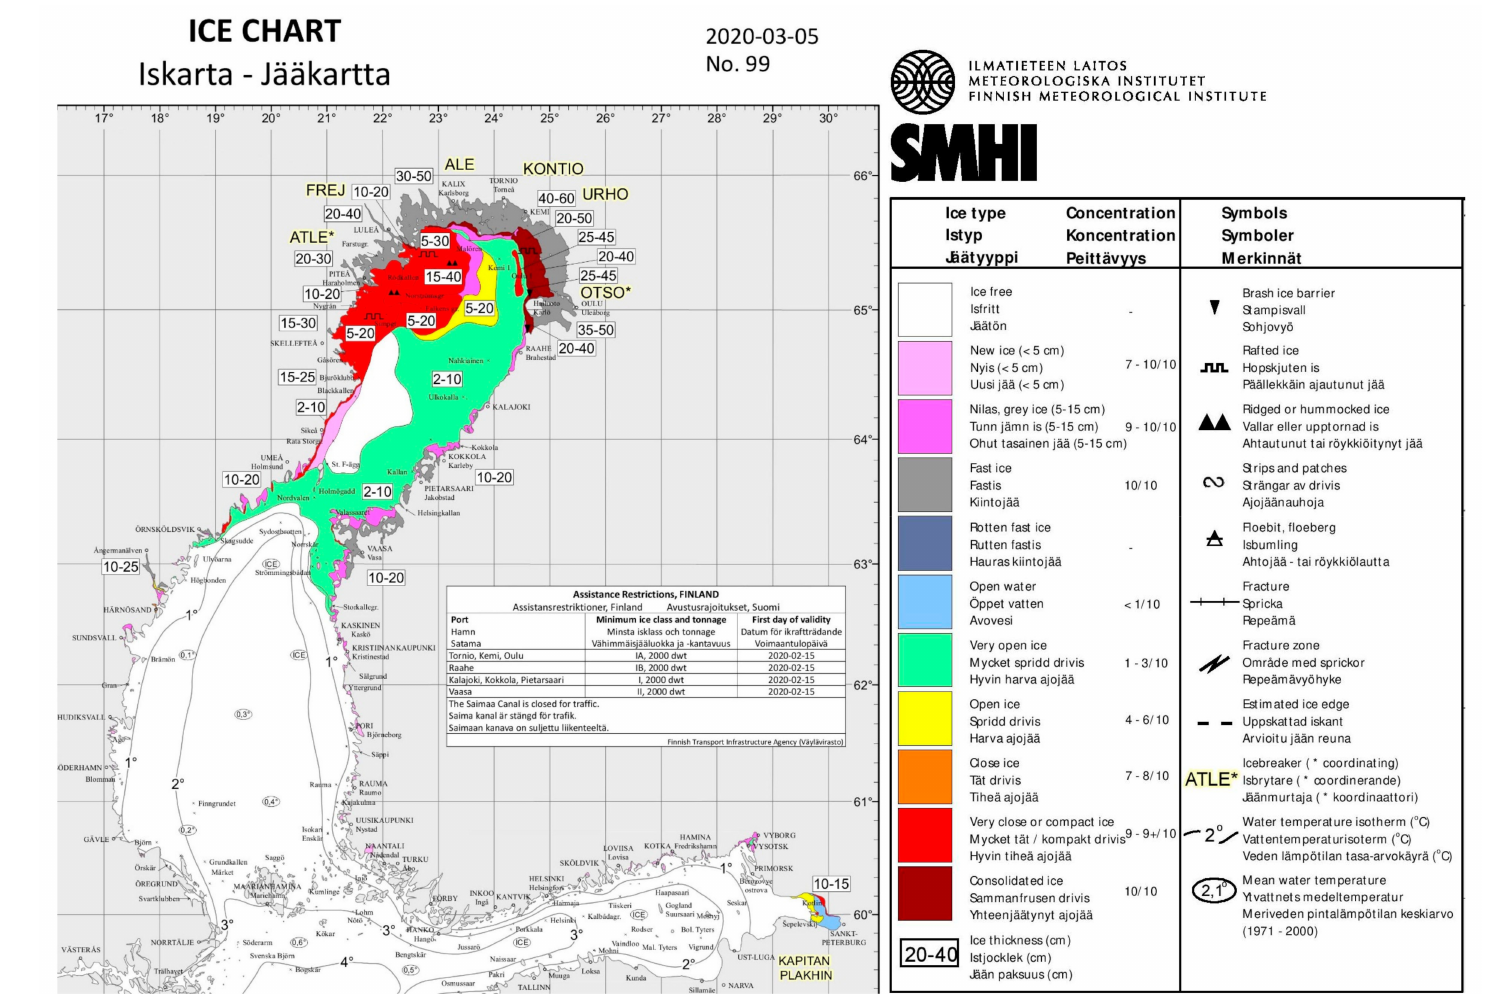
Figure 4. Baltic Sea ice chart by Finnish Ice Service (FIS) and Swedish Meteorological and Hydrological Institute (SMHI) on 5 March 2020 when the Baltic Sea ice had the largest extent during the ice season 2019–2020. Grey color shows extent of landfast ice based on visual analysis of EO imagery, mainly